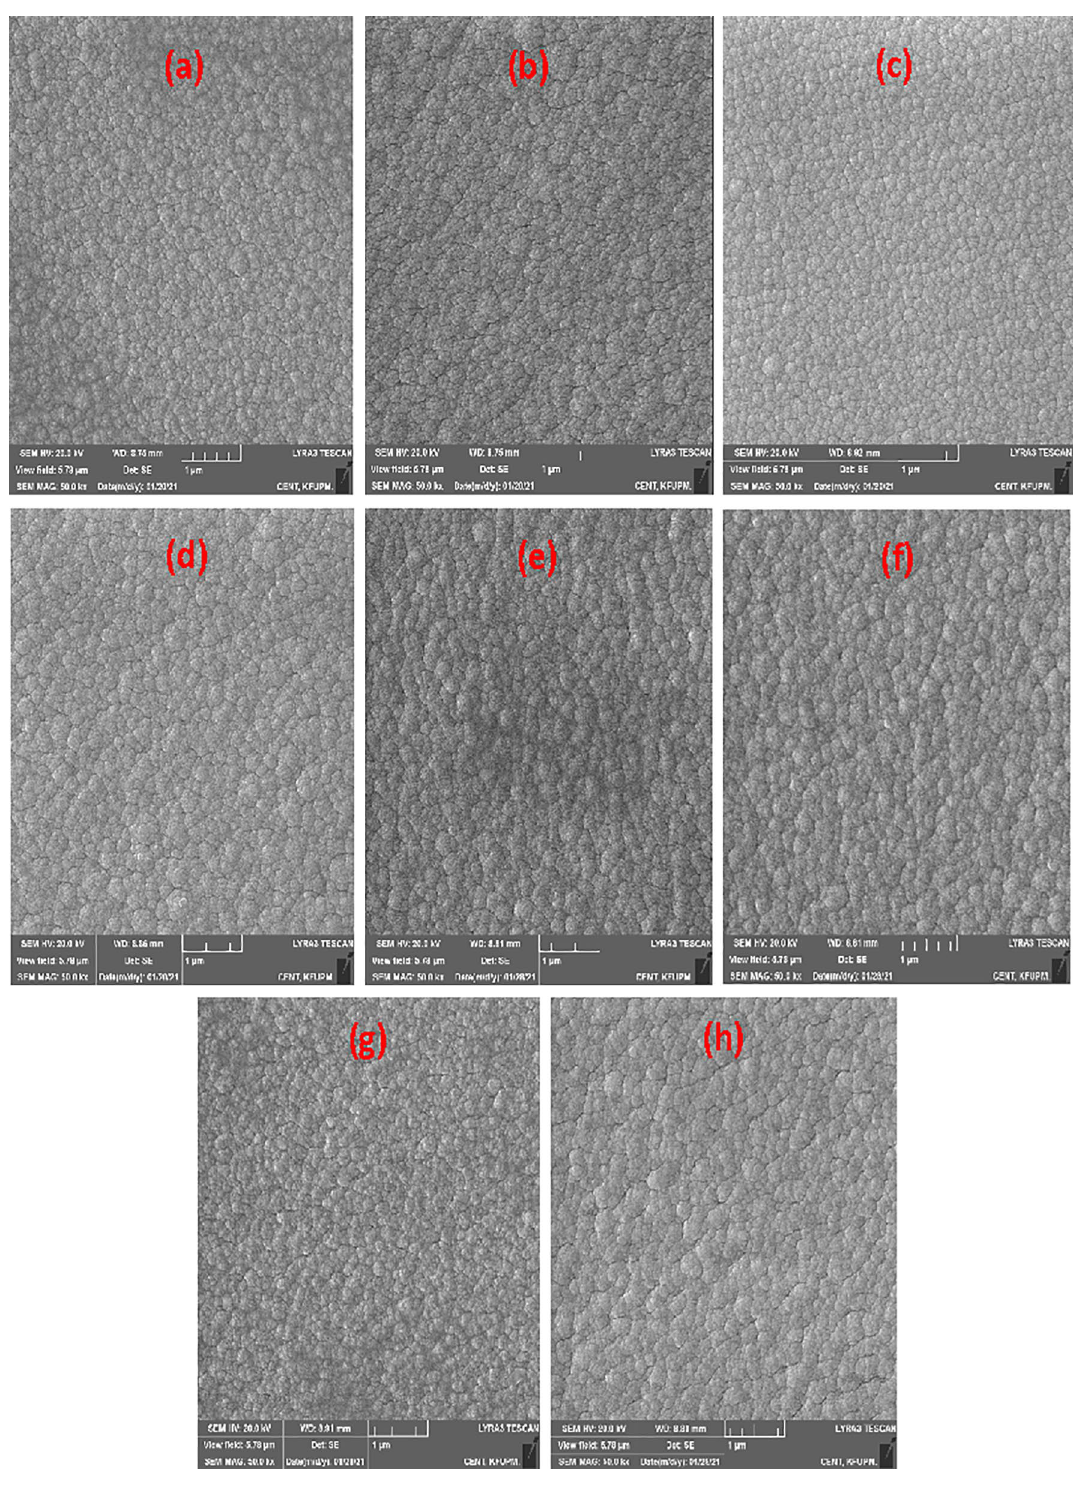
Figure 6. High magnification FESEM micrographs of ( a ) PN7, ( b ) PN8, ( c ) PN9, ( d ) P10, ( e ) PN11, ( f ) PN12, ( g ) PN13 and ( h ) PN14 coatings’ top